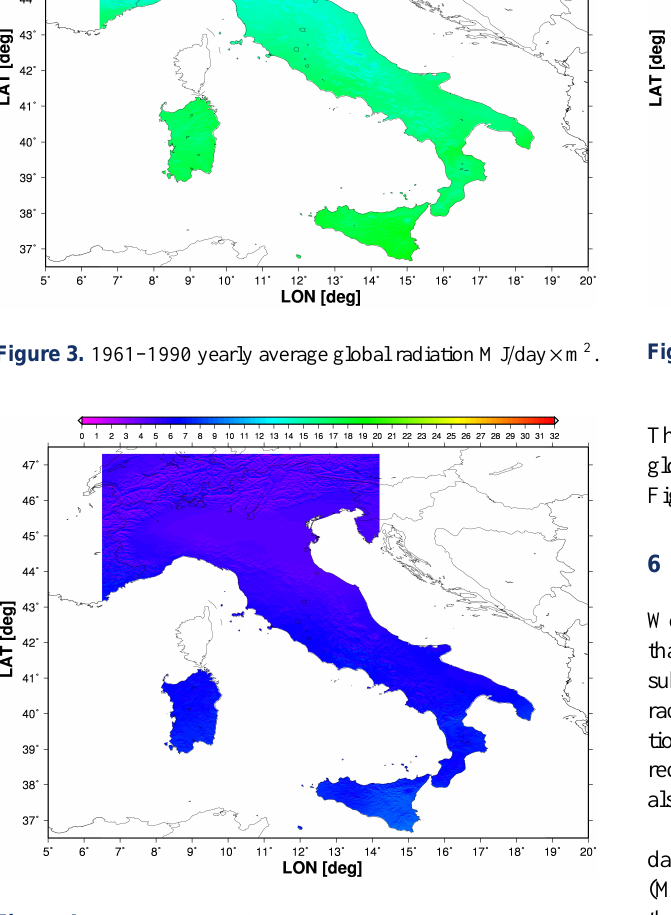
Figure 4. As in Fig. 3, but for January.